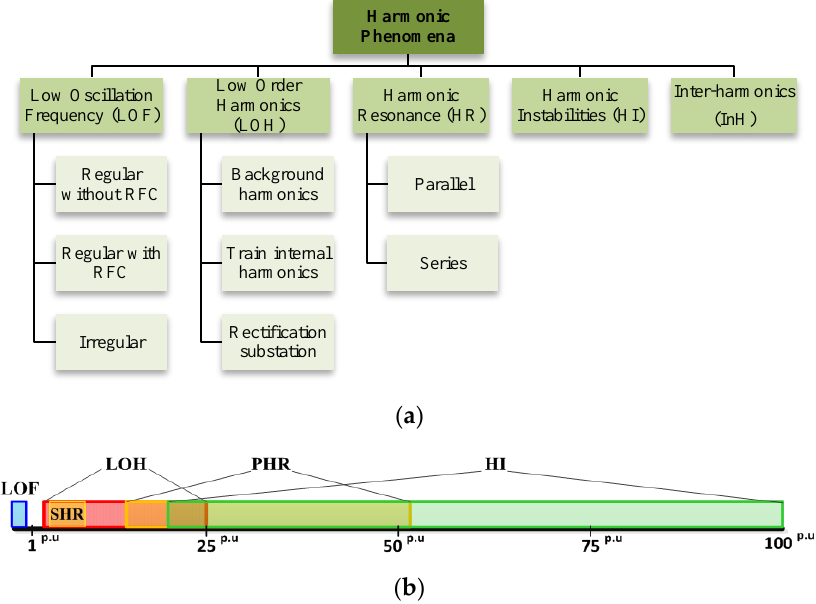
Figure 8. Classification of harmonic indexes in ERPS. ( a ) Organization chart. ( b ) Occurrence frequency